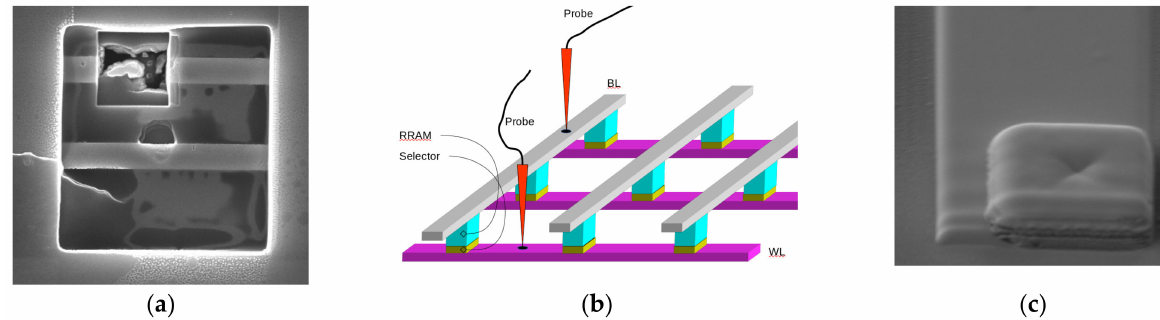
Figure 2. ( a ) Silicon edition with a 6 × 6 µ m 2 open is made on the passivation layer to access the metal routing layers in a 65 nm CMOS technology chip. The inset open shows a lower connection via. ( b ) With direct contact probes, RRAM resistances can be passively measured using reverse engineering techniques. ( c ) After the FIB edition, extra deposition of metallic layers export connections below to the surface in order to ease the contact with probes. Pictures are from a hacked 65 nm chip reverse-engineered in CRnE-UPC-BarcelonaTech. The chip itself does not contain RRAMs but it illustrates the power of the FIB